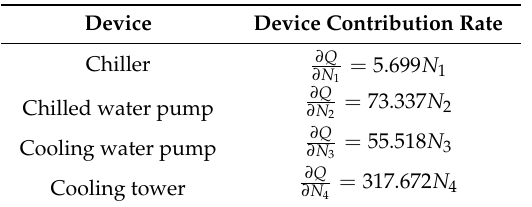
Table 10. Device contribution rate of chilled station